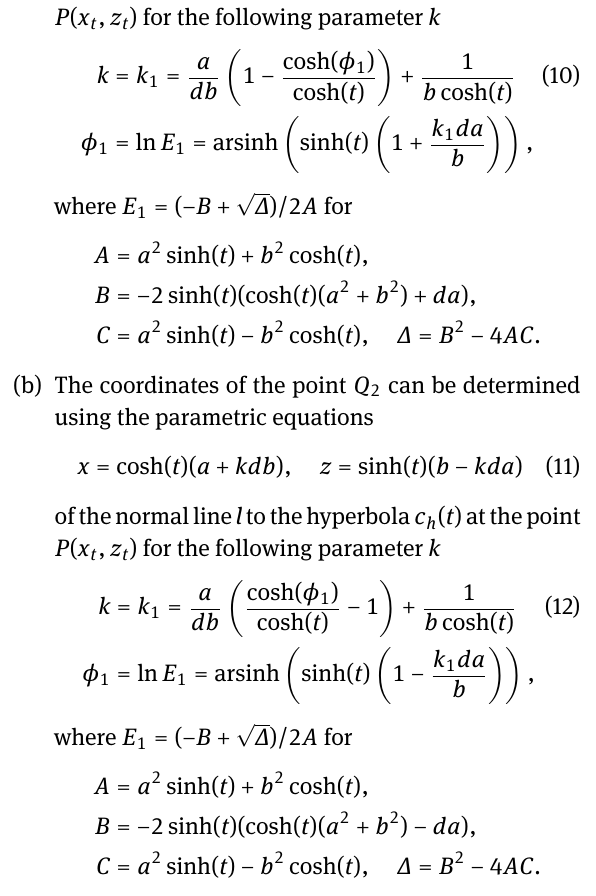
is coloured dark blue. The use of the offset surface ( i.e. hori- zontal offset thickness) could reinforce the structure of the chimney wall. The wall would be more resistant to wind force. The surfaces s ( t , v ) and s ( ϕ , v ) were cut out to h h 1 show the next layer (see Figure